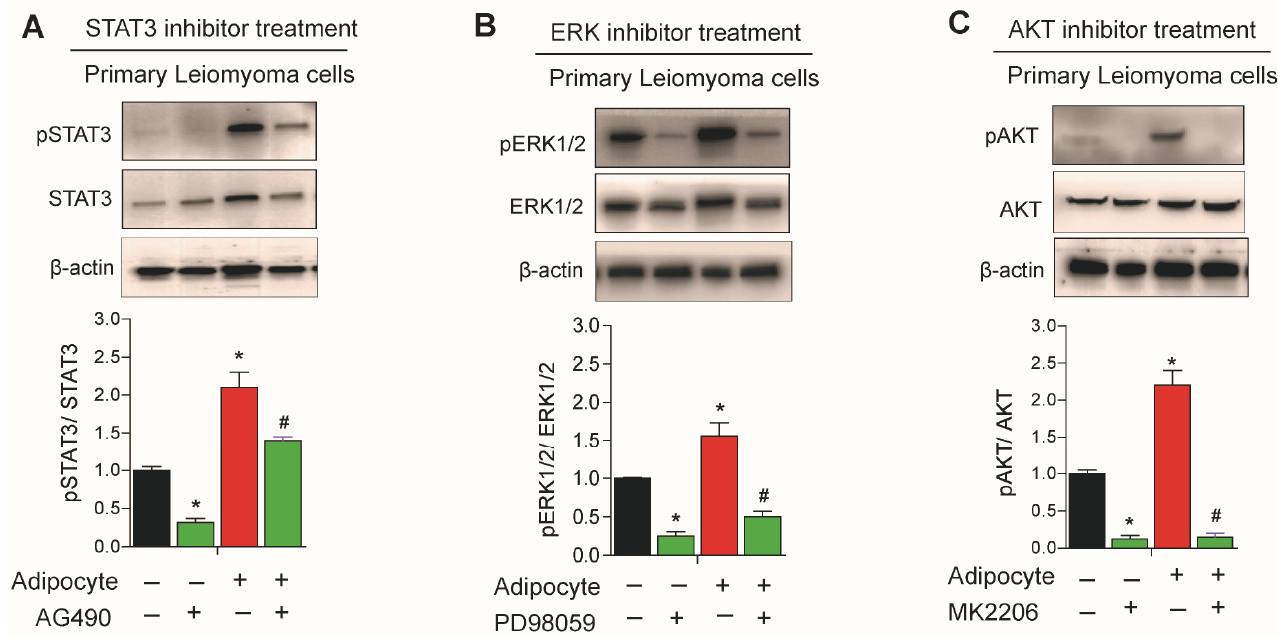
Figure 6. Effect of STAT3, ERK and AKT inhibitor treatment in uterine leiomyoma cells. Primary human leiomyoma cells were cultured with SW872 adipocyte cells. After seven days, primary leiomyoma cells cultured in the presence and absence of adipocytes were treated for 24 h with the STAT3 inhibitor (AG490; ( A )), the ERK inhibitor (PD98059; ( B )), and the AKT inhibitor (AM2206; ( C )) before a Western blot analysis of pSTAT3/STAT3, pERK1/2/ERK1/2, and pAKT/AKT abun-